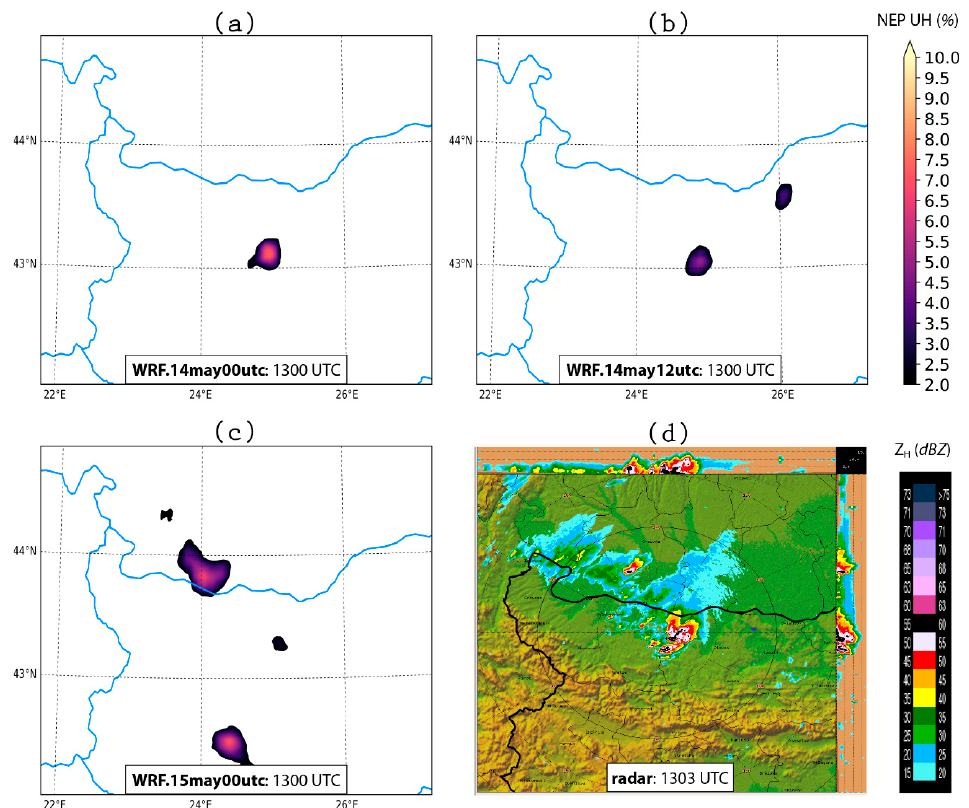
Figure 13. Forecasts of supercell strengthening from ( a ) WRF.14may00utc, ( b ) WRF.14may12utc and ( c ) WRF.15may00utc at 13:00 UTC compared against ( d ) composite reflectivity observations at 13:03 UTC. Interpretation of the figures remains the same as in Figure 11.